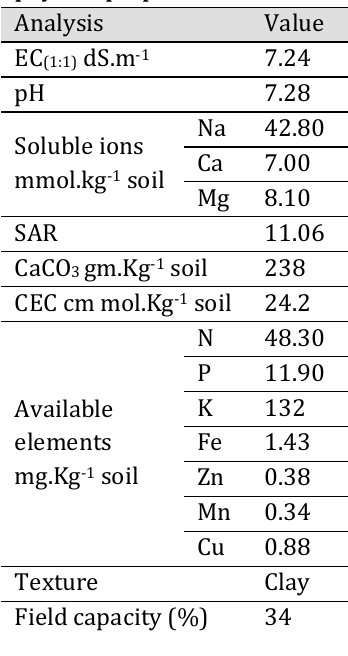
physical properties of